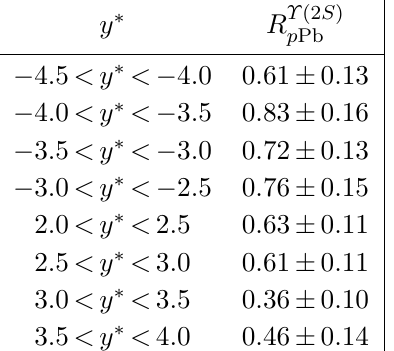
Table 15 . (cid:7) (2 S ) nuclear modi(cid:12)cation factor, R (cid:7) (2 S ) over p T in the range 0 < p T < 25 GeV =c